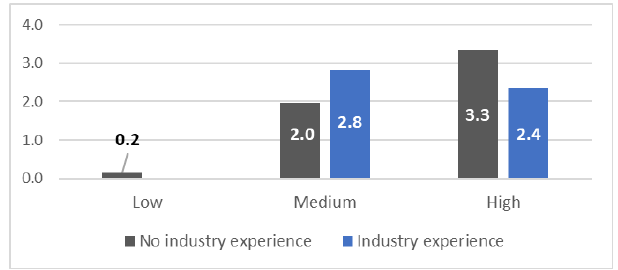
Fig. 12. Mean of the number of defects per severity level in